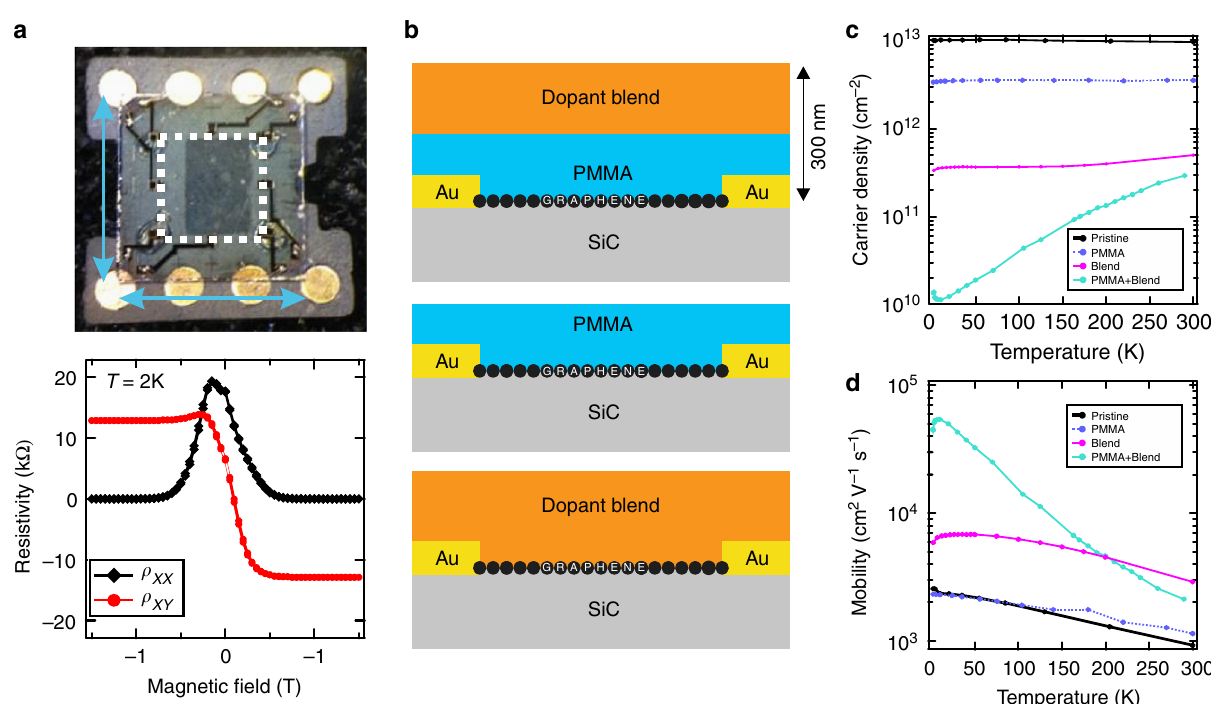
Fig. 1 Magnetotransport characterization of chemically doped SiC/G. a Top: macroscopic graphene Hall bar device (white dotted outline, W = 5 mm × L = 5 mm). Bottom: low fi eld magnetoresistance and fully developed quantum Hall effect indicating low charge disorder in chemically doped graphene, even over macroscopic areas. For this device, the measured carrier density p = 9 × 10 9 cm − 2 and mobility μ = 67 000 cm 2 V − 1 s − 1 . b The different encapsulation schemes with a polymer stack consisting of PMMA-F4TCNQ dopant blend, which comprises of F4TCNQ molecules in a PMMA matrix (F4TCNQ 7 wt%). The three schemes are dopant blend separated from graphene by a PMMA spacer (top), only PMMA layer (middle), and the dopant blend directly on the surface of graphene (bottom). c Carrier density as a function of temperature extracted from Hall measurements on small epitaxial graphene devices ( W = 2 – 50 μ m × L = 4 – 180 μ m). d The corresponding Hall carrier mobility showing the highest μ ~ 55 000 cm 2 V − 1 s − 1 at T = 10 K for sample prepared with PMMA spacer and dopant layer. The downturn in mobility at lower temperatures is due to quantum corrections to the Drude resistance. Carrier concentration n and mobilities μ were extracted from Hall measurements as n = 1/ eR H and μ = R H / ρ XX , with e the elementary charge, the Hall coef fi cient R = d R B , the longitudinal sheet resistance ρ = R W / L , and R XY /d XX XX XY the transversal resistance H